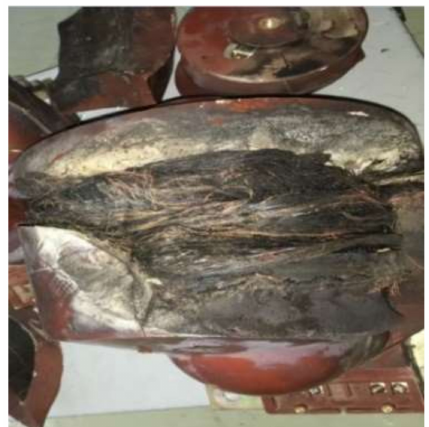
Figure 1. Winding damage of voltage transformer (VT) for